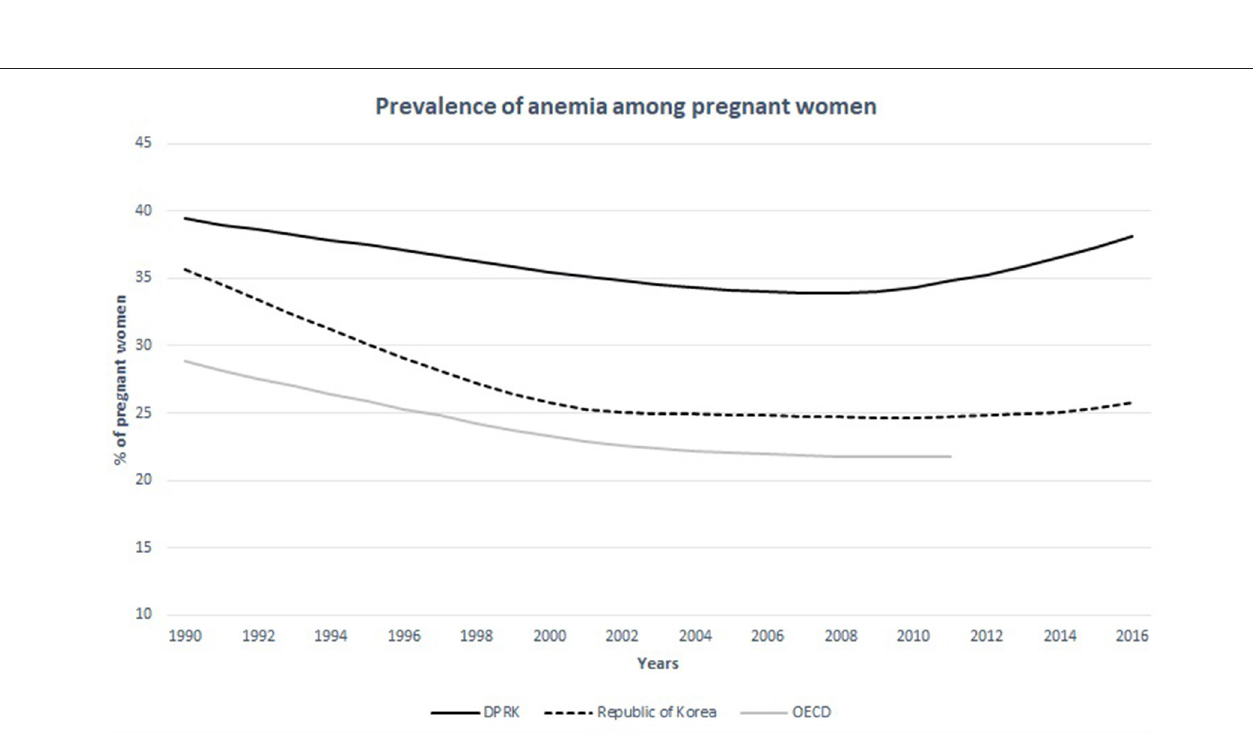
Frontiers in Public Health |